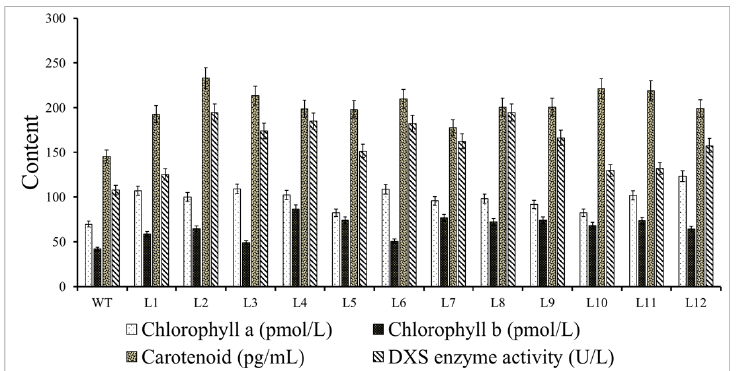
Figure 8. Contents of chlorophyll a, chlorophyll b, and carotenoids and 1-deoxy-D-xylose-5-phosphate synthase (DXS) enzyme activity in the transgenic lines and wild type (WT) A. thaliana .